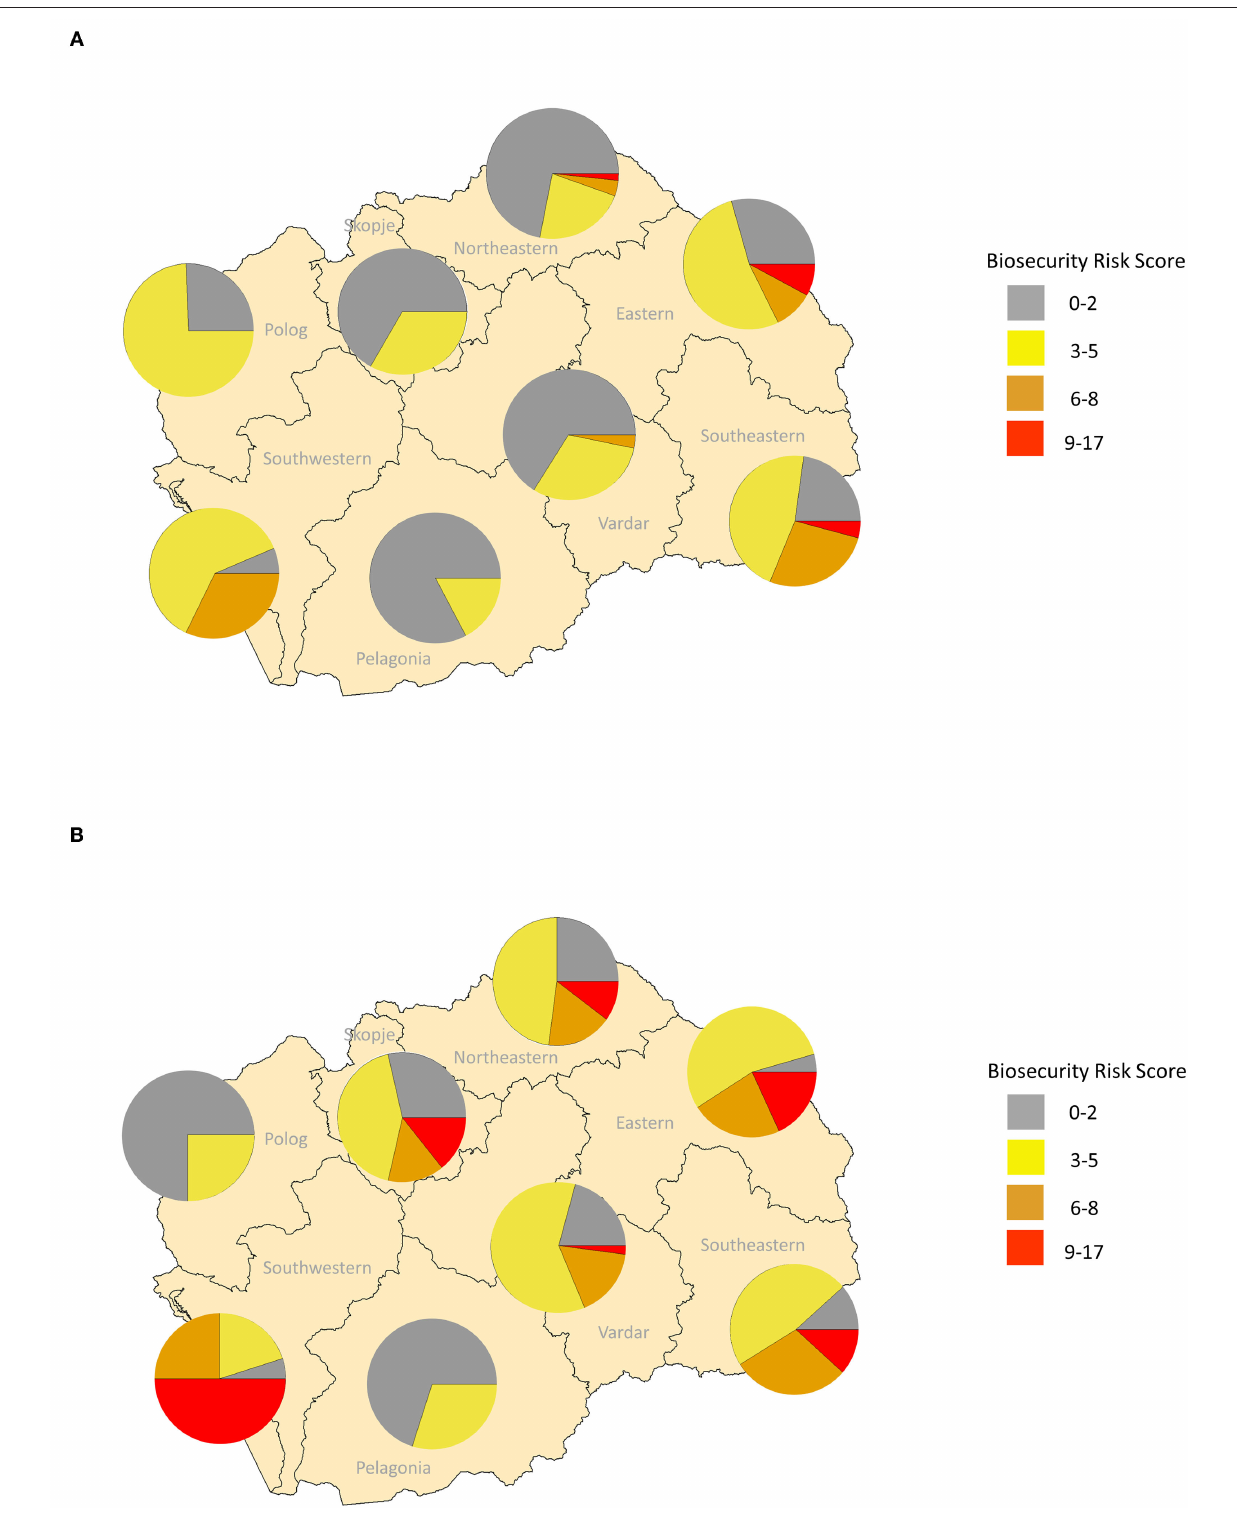
FIGURE 7 | Mapping of biosecurity risk score by North Macedonian region. Pie charts represent the proportion of pig farms with the corresponding biosecurity risk scores in each region for (A) all farms, and (B) family and commercial farms. Biosecurity risk scores represent a non-weighted linear combination of values assigned to dichotomized survey questions collected between September 2019 and March 2020 in which higher scores represent higher risk.